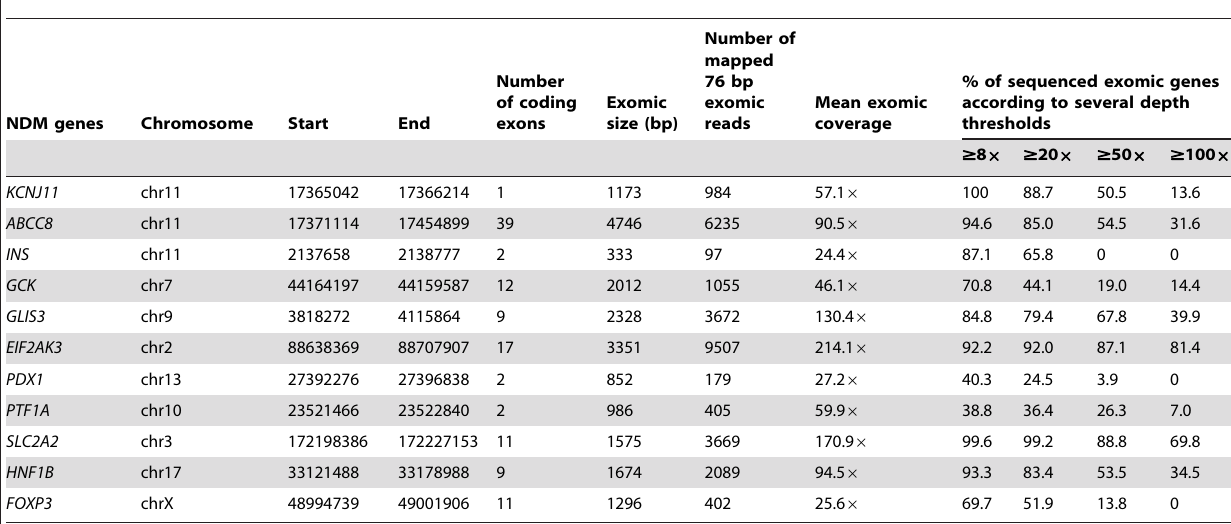
Table 2. Details on exomic sequencing depth in NDM genes, obtained through the WES of the PNDM patient.